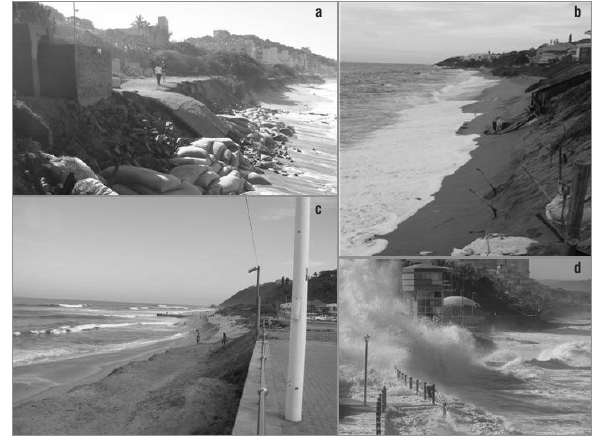
(a) Umdloti, (b) Little Maritzburg Road, (c) Ansteys and (d) Umhlanga beaches during a large swell. These locations are known erosion hotspots.